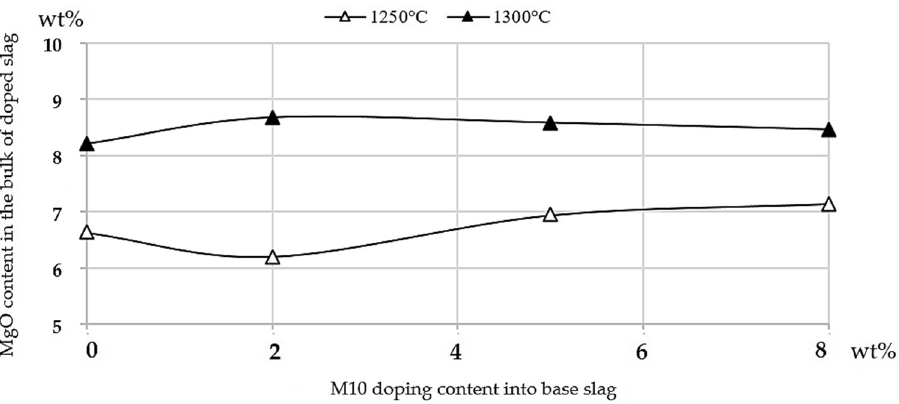
Figure 7. Magnesia content in the bulk of the doped slag v/s the initial M10 doping content, measured by XRD-WPPF.